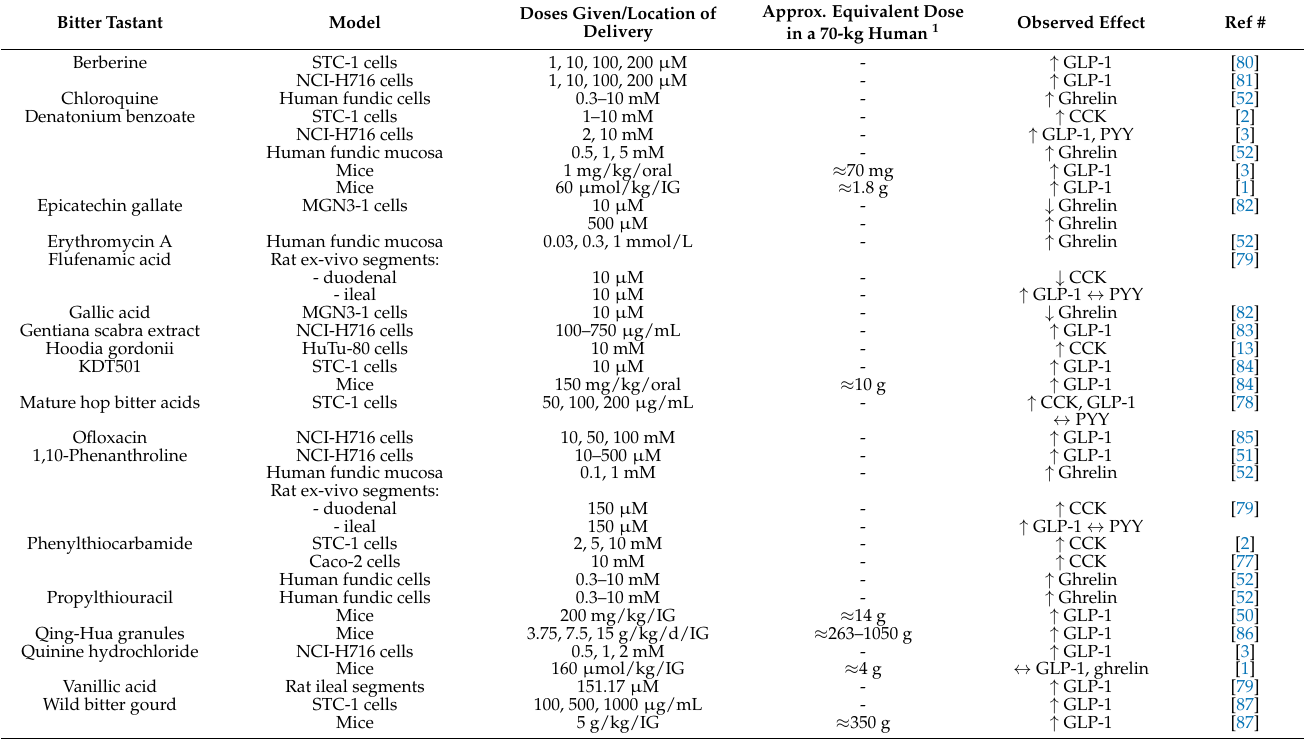
Table 1. Effects of bitter substances on gut hormone secretion in preclinical models. Bitter